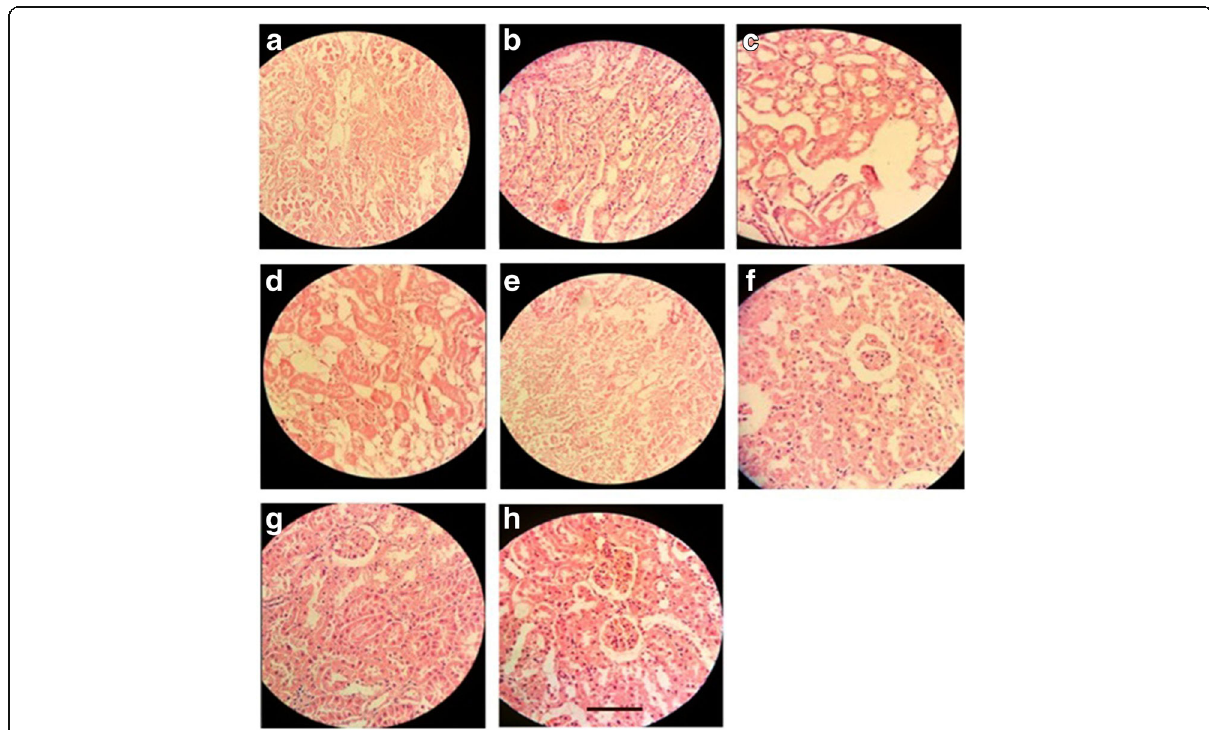
Fig. 6 Histopathological changes in the right kidney; a : Group I = Normal control, b : Group II = Diabetic wound control, c : Group III = Diabetic wound control +100 mg ethanolic extract of E. hirta , d : Group IV = Diabetic wound control +200 mg ethanolic extract of E. hirta , e : Group V = Diabetic wound control +400 mg ethanolic extract of E. hirta , f : Group VI = Diabetic wound control +5% Povidone iodine, g : Group VII = Diabetic wound control +5% ethanolic extract of E. hirta , h : Group VIII = Diabetic wound control +10% ethanolic extract of E. hirta . Each group was assessed at 400X magnification, scale bar: 40 μ